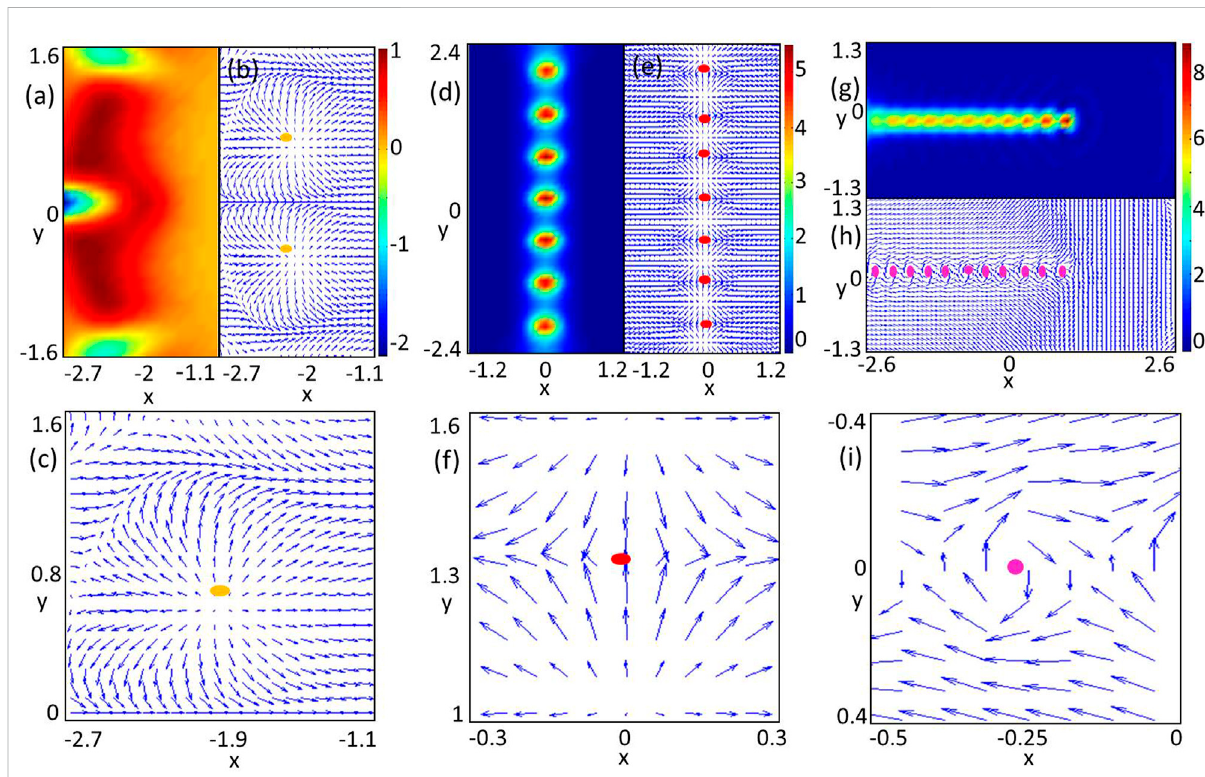
FIGURE 5 (Color online) Topological charge densities and spin textures. (A) Topological charge density, (B) the corresponding spin texture, and (C) the localampli fi cationofthespintexture,wherethegroundstateisgiveninFigure2E. (D) Topologicalchargedensity, (E) thecorrespondingspintexture, and (F) the local ampli fi cation of the spin texture, where the ground-state is shown in Figure 3E. (G) Topological charge density, (H) the corresponding spin texture, and (I) the local ampli fi cation of the spin texture, where the ground state is seen in Figure 3F. Note that the yellow spots in (B) and (C) denote radial-out skyrmion, the red spots in (E) and (F) present hyperbolic skyrmion, and the purple spots are circular